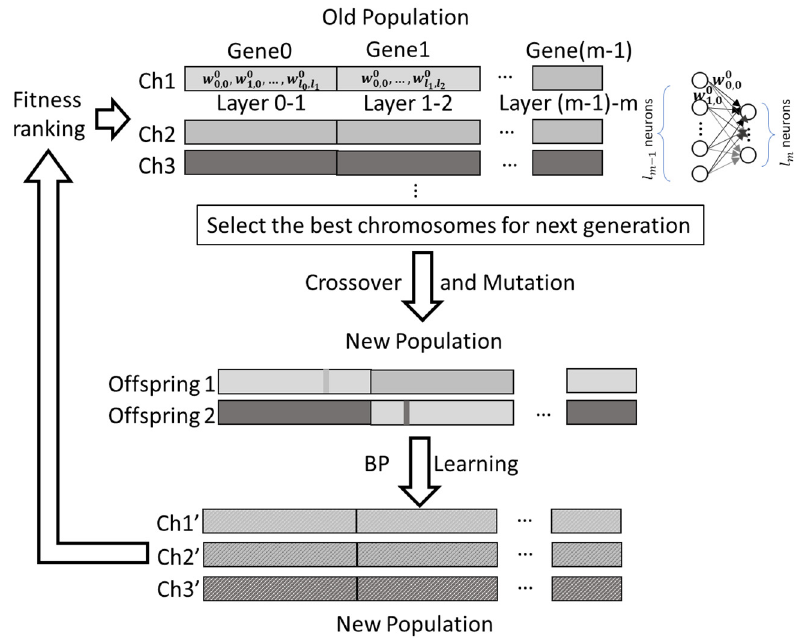
Figure 12. The GA flow chart .